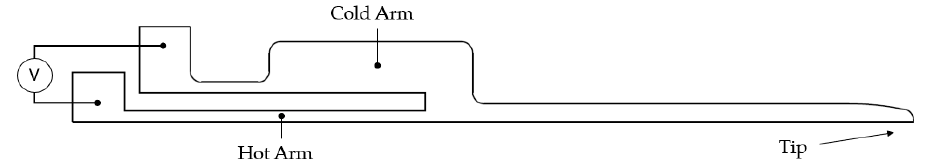
Figure 1. A 2-dimensional plan view representation of a typical U-shaped electrothermal actuator (ETA) (only half of the mechanism is shown).